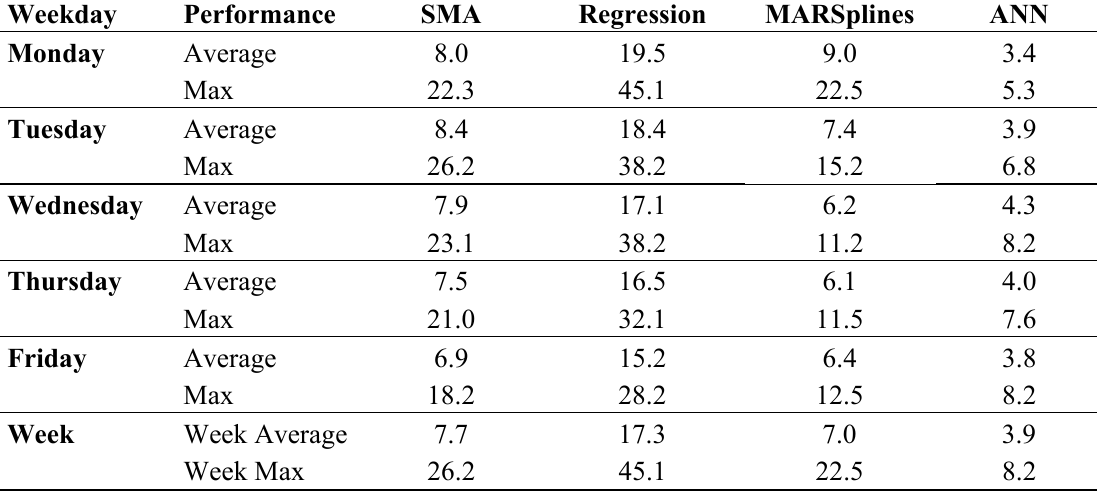
Table 3. Average sixty-minute forecast errors (%) (twenty four-hour period) electrical kW demand vs.